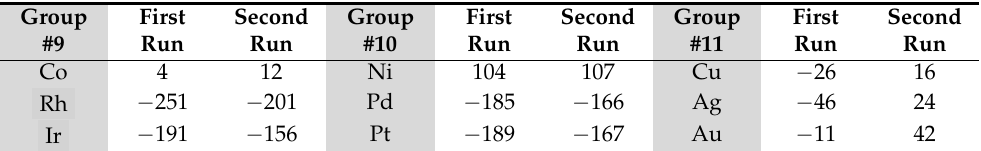
Table 2. Differences in CO oxidation onset temperatures (T Al2O3,onset − T M-Al2O3,onset ) in the first and second runs, compared with that of bare Al 2 O 3 nanosheets. The CO oxidation onset temperatures